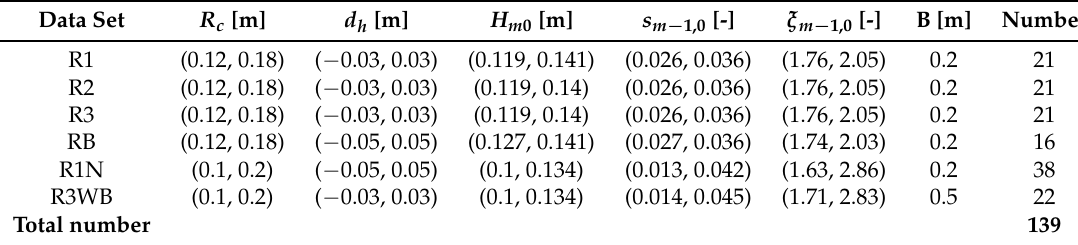
Table 1. Summary of parameter ranges of all